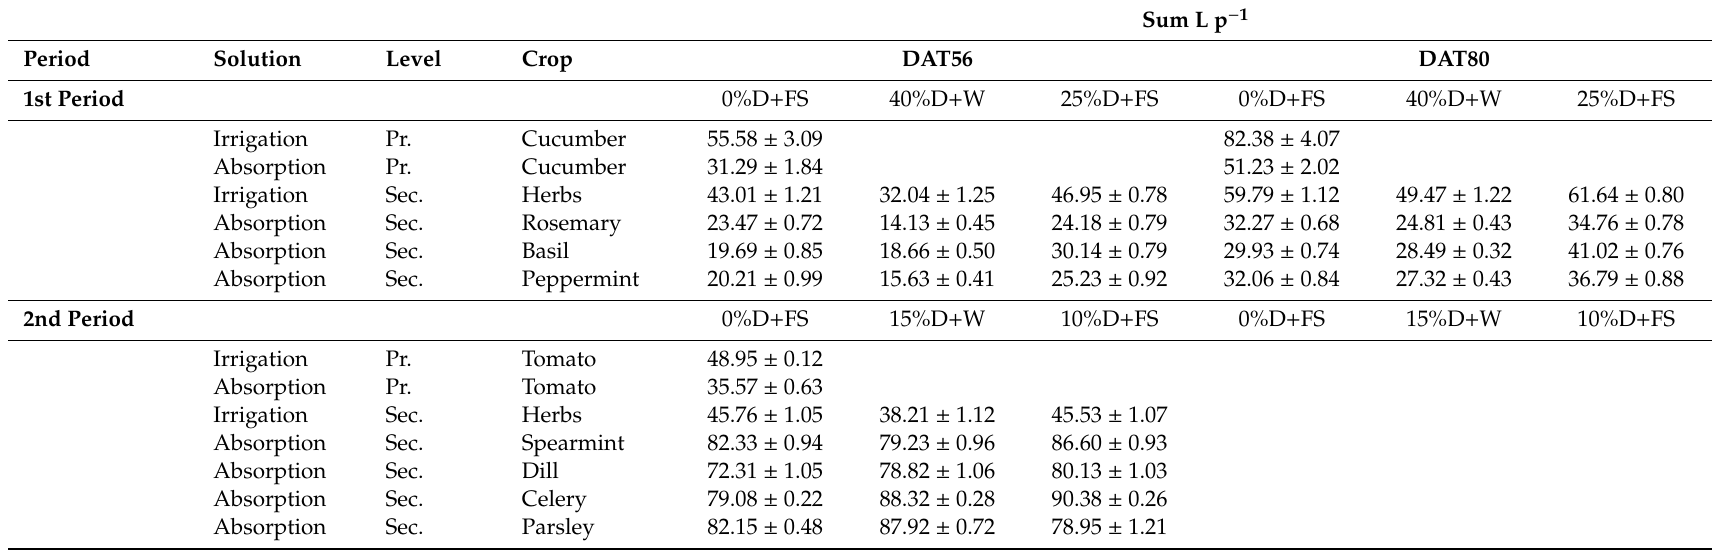
Table 1. Mean values (and standard deviation) of the total amount of NS supplied to the primary and secondary crops (IS) and of NS absorbed by the plants according to the substrate and the fertigation treatment in the 1st and 2nd Periods,